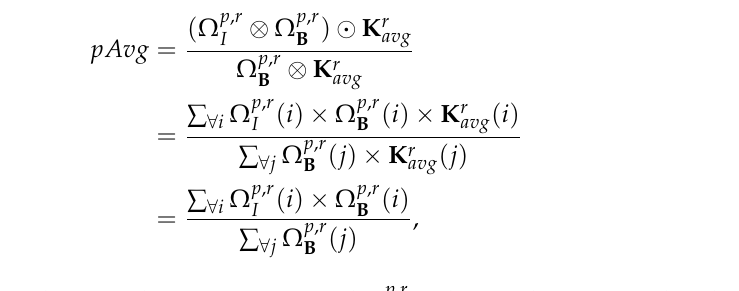
and Ω p , r , respectively. Here, p = ( 4,4 ) and r = B I